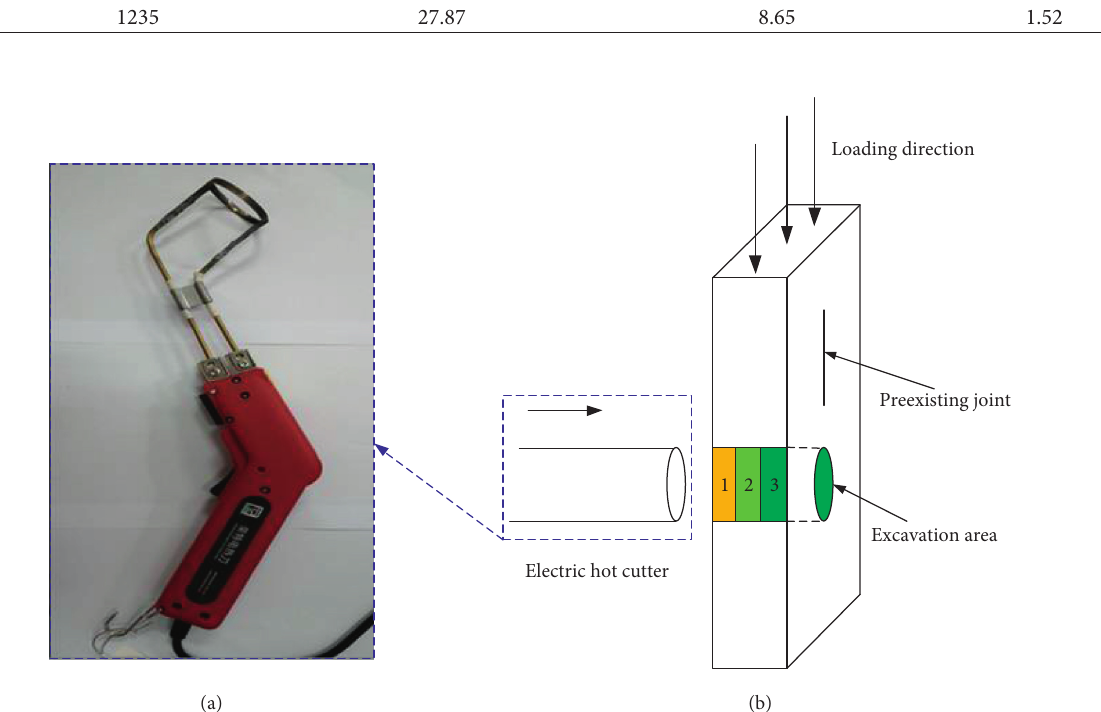
Figure 2: (a) Electric hot cutter. (b) Schematic diagram of the stepped excavation